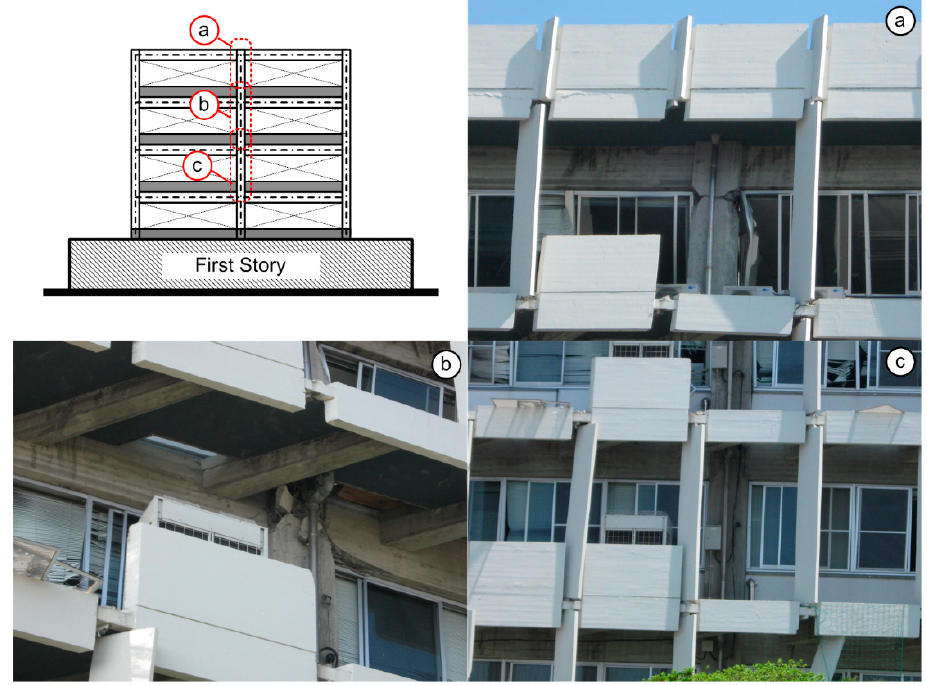
Figure A3. Simplified elevation and photographs of the south elevation. Photographs show damage to ( a ) a fifth-story column, ( b ) a beam–column joint at the top of the fourth story, and ( c ) a third story column.